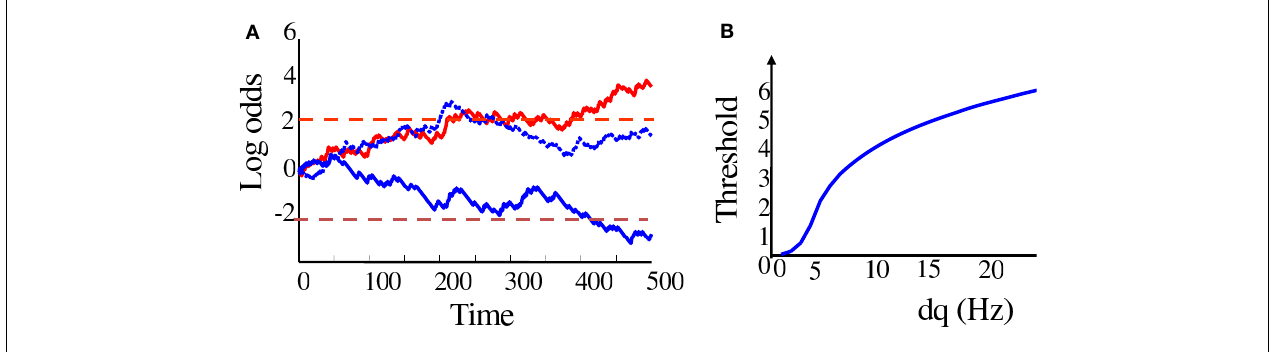
correct trial where choice B was made (the lower decision threshold was reached first) and B was indeed the correct choice. Dotted blue line: an error trial where choice “A” was made while choice “B” would have been the correct choice. (B) Optimal decision thresholds as a function of the strength of the modulation of input firing rate by motion direction ( dq